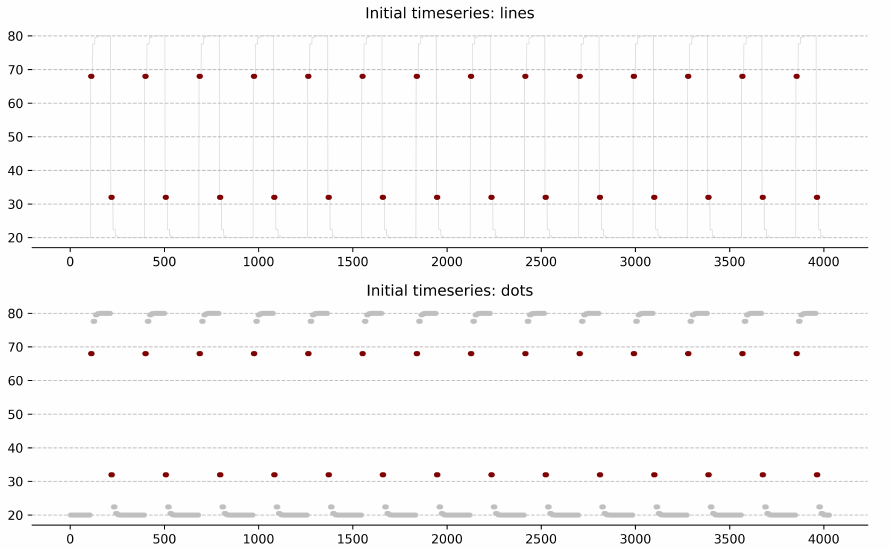
Figure 17. Numenta Anomaly Benchmark time series with no anomalies. No anomalies: artificial repeating